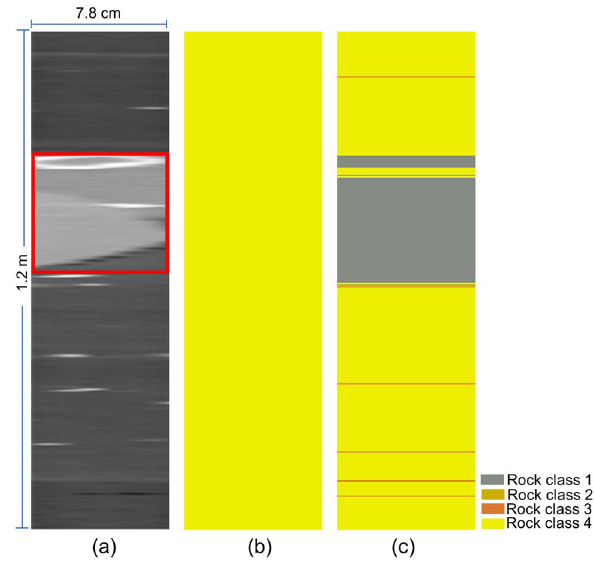
Fig. 17 Zoomed interval of the test set (approximately 1.2 meters), where the CNN classifier is able to pick the calcite nodule. a 2D cross section of the input CT images, b Rock classes from manual core description, c Predicted rock classes using the scaled-up clas-